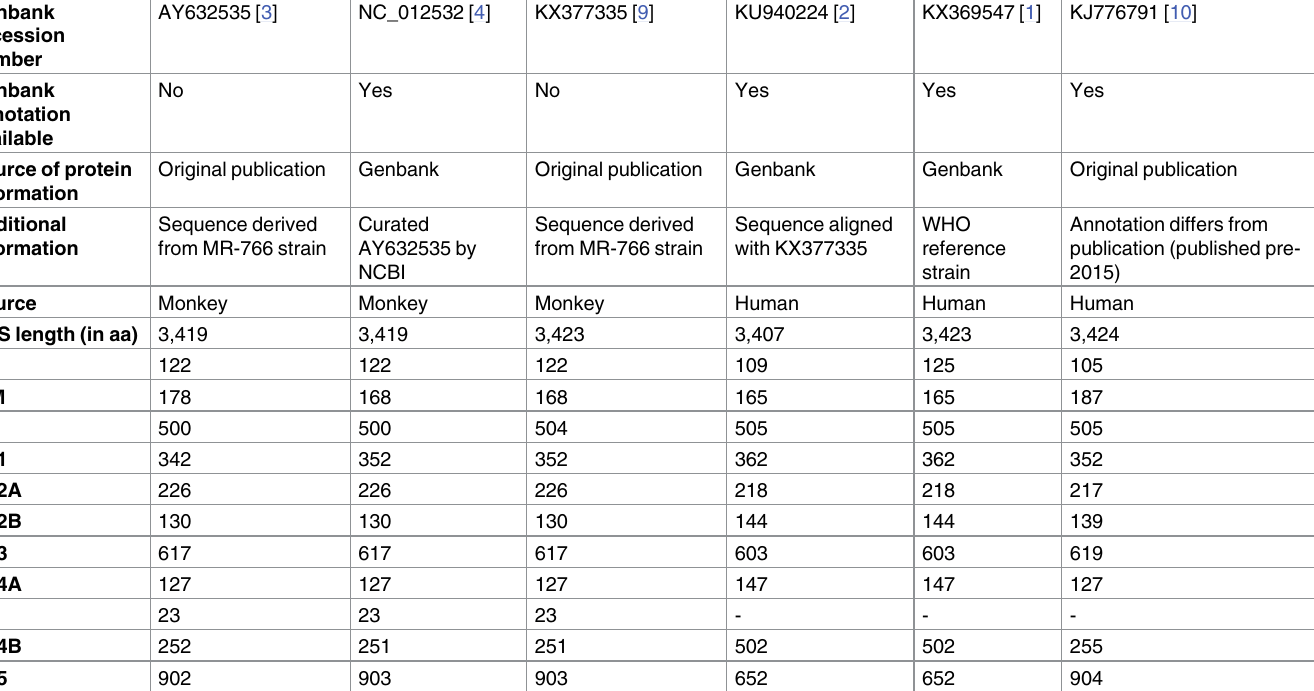
Table 1. High level of heterogeneity in reported peptide lengths of ZIKV from genome annotations available in Genbank or protein information reported in original